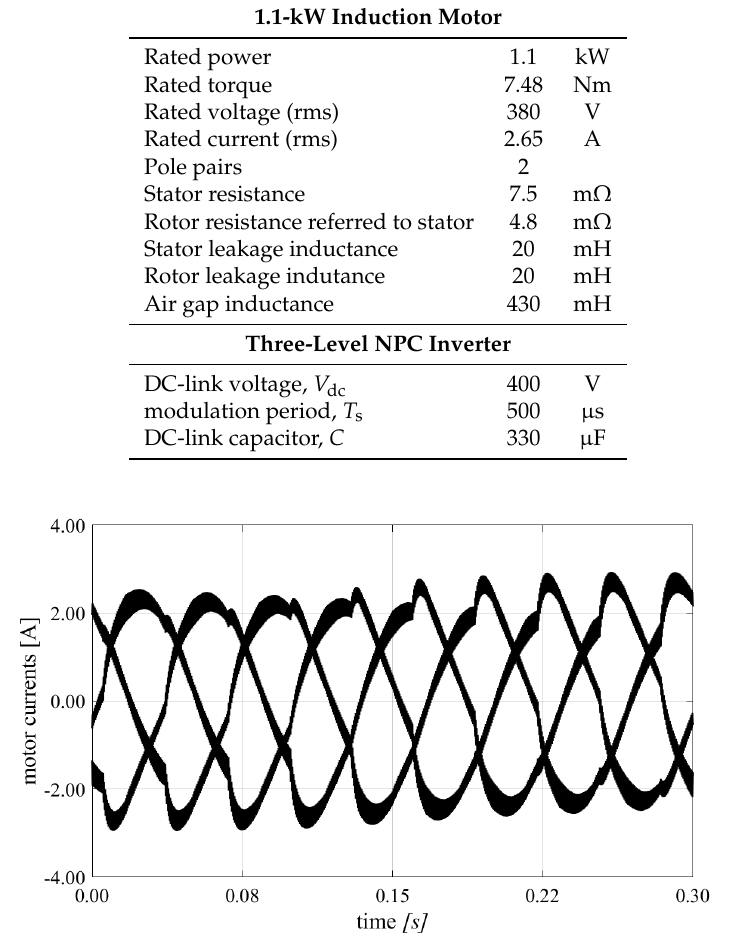
Figure 4. Numerical result: motor currents achieved with the traditional SVM, when m = 0.27, v ∗ = v ∗ = 200 V, and T l = 3.5 Nm. C1 C2